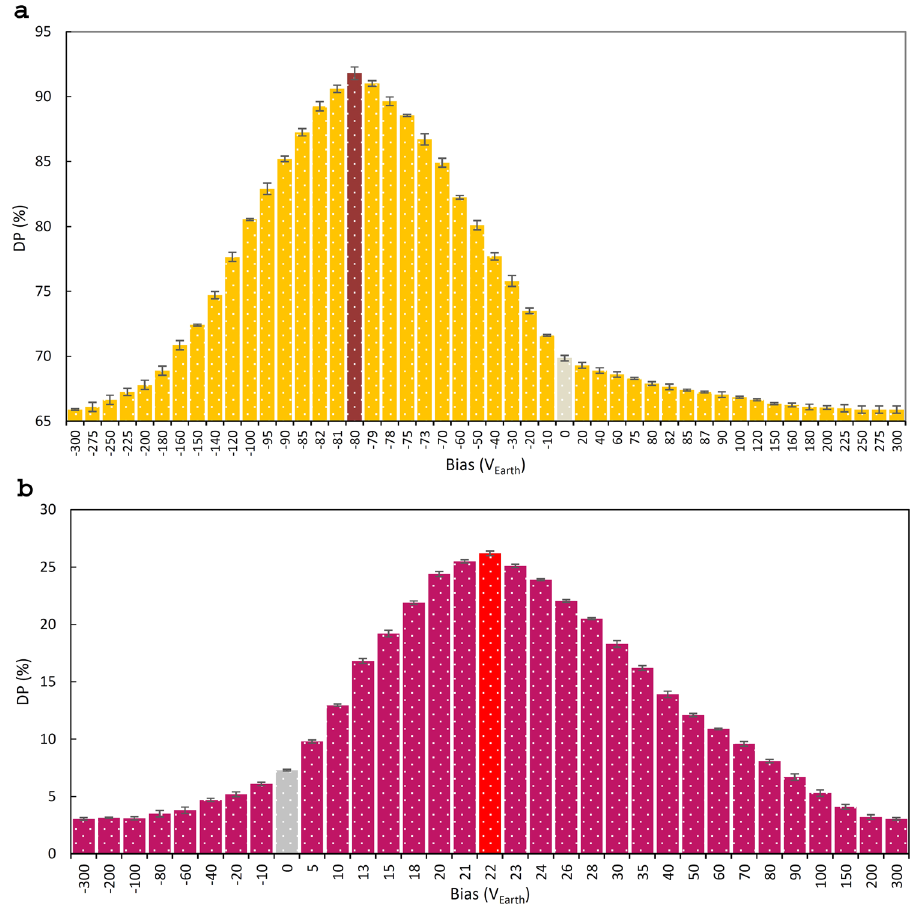
Fig. 5 Electrostatic bias effect on hematite photoreactor performance. Diagrams are plotted for ( a ) cationic malachite green and ( b ) anionic methyl orange dyes (the error bars are standard deviation). Table 1. Optimum electrostatic bias values (in V w.r.t. Earth) determined for pyrite and hematite semiconductors (the biases applied in a single-electrode reactor for photo-electrostatic removal of malachite green (MG) and methyl orange (MO) dyes in aqueous media).